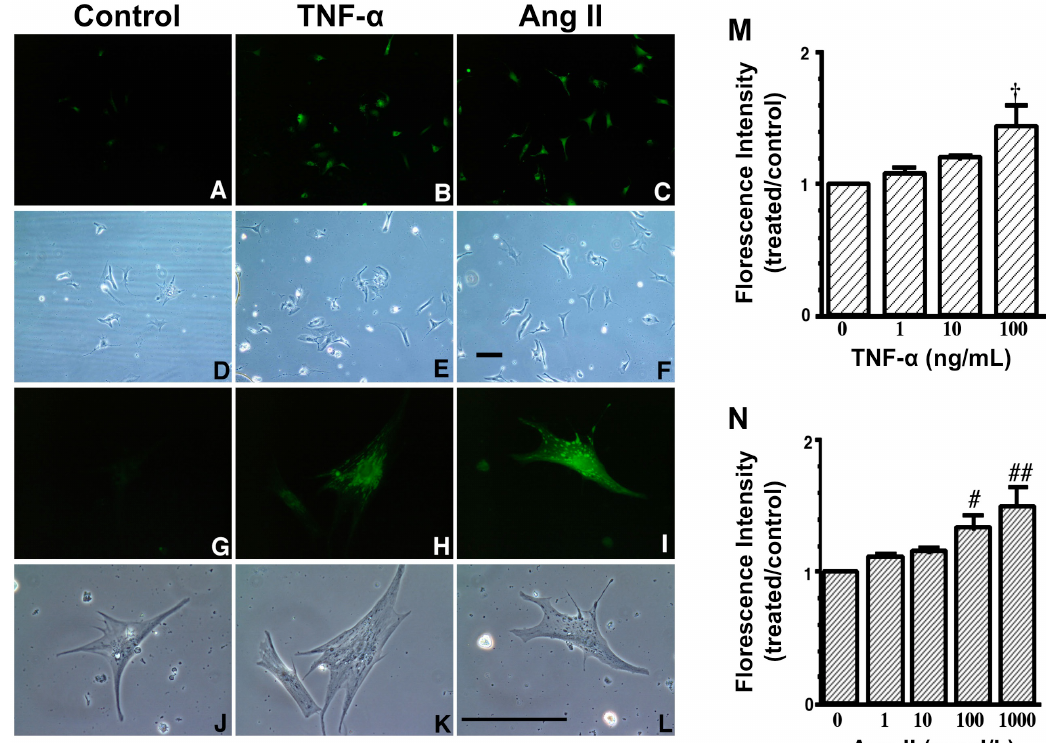
Figure 4. Generation of ROS in neonatal rat cardiac myocytes induced by tumor necrosis factor- α (TNF- α ) and angiotensin II (Ang II)